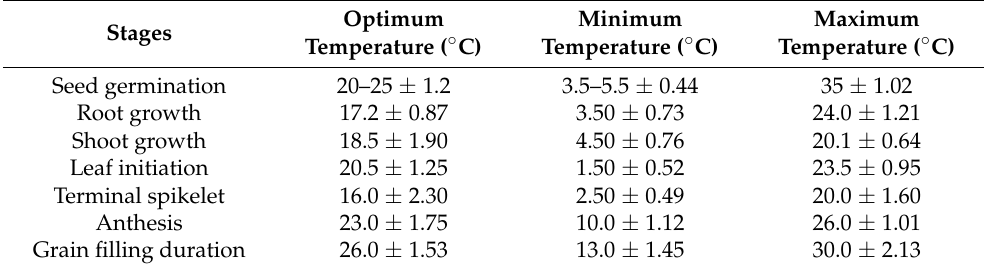
Table 1. Optimal temperature requirements of wheat at different growth stages (Adopted from Khan et al.